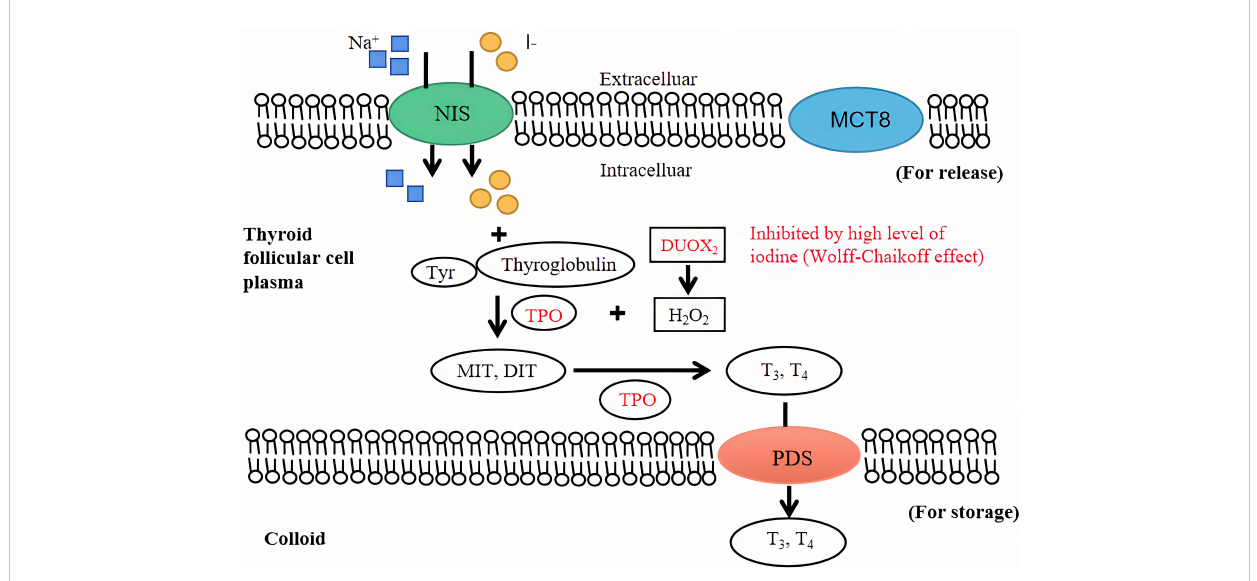
FIGURE 1 The mechanism of iodine in the thyroid gland. An intuitive view of the mechanism of normal and high iodine levels on the thyroid gland and thyroid hormone synthesis. The inhibition of high iodine levels on thyroid hormone synthesis (Wolff-Chaikoff effect) is shown in red. NIS, sodium iodide symporter; TPO, thyroid peroxidase; MIT, monoiodo-tyrosine; DIT, diiodo-tyrosine; T3, triiodothyronine; T4, thyroxine; PDS, anion exchanger pendrin; MCT8, monocarboxylate transporter